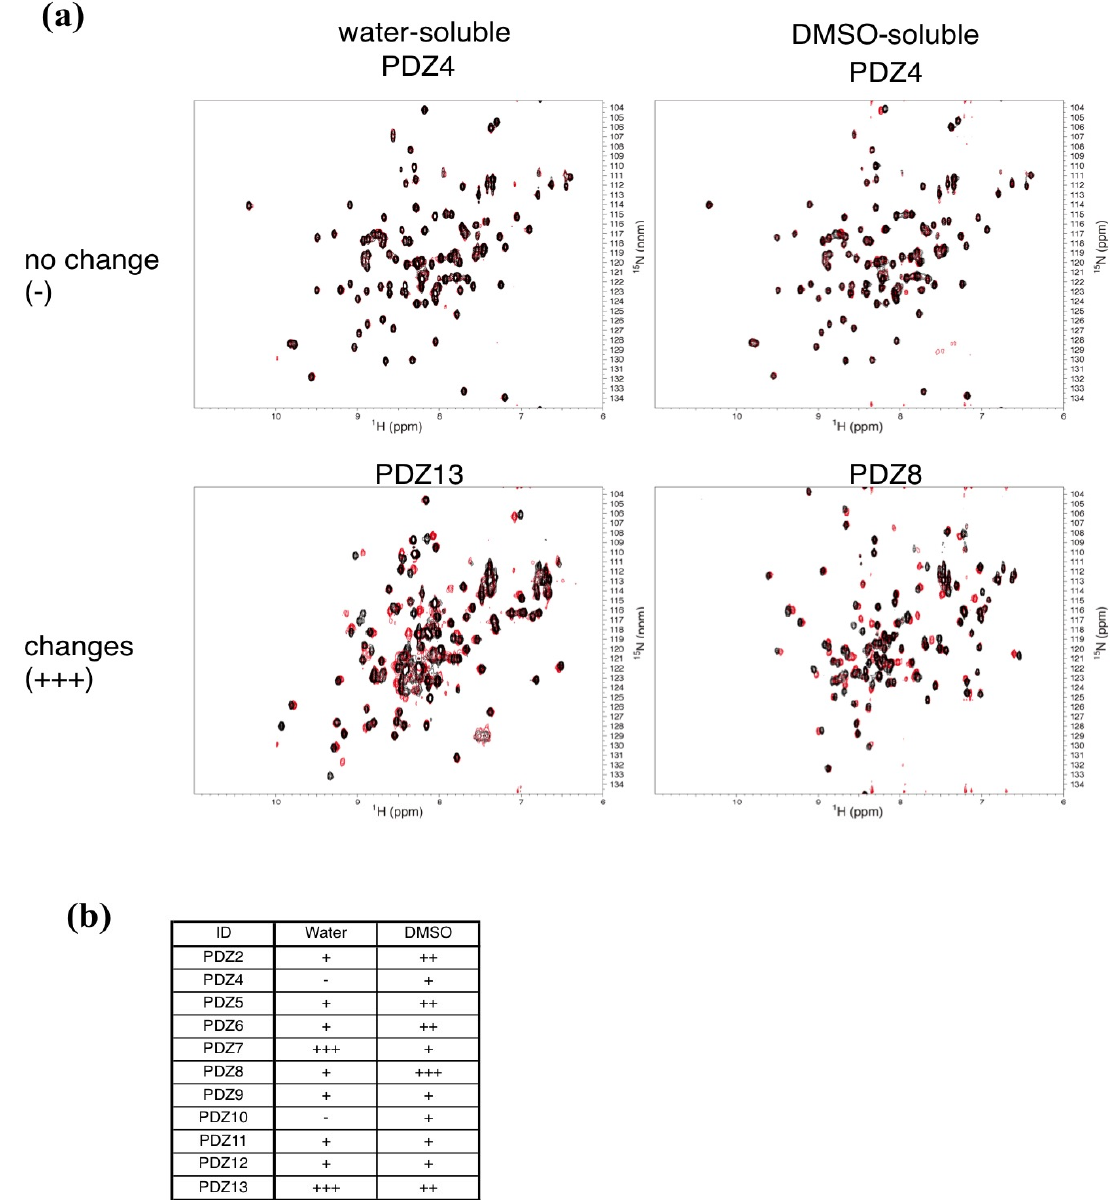
Figure 1. Examples of NMR-binding assay between PDZ domains and the compound cocktails. ( a ) Each overlaid spectrum was derived from a PDZ domain with (red) and without (black) cocktail. Upper spectra show that no signal changes were observed with mixing of the PDZ domains and a cocktail. Lower spectra show the signal changes when PDZ domains were mixed with a cocktail. ( b ) Summary table of binding assays using compound cocktails. The number of the plus signs indicates the degree of signal changes (+, less than 15 signals changed; ++, less than 30; +++, over 30, respectively). The minus sign indicates no signal changes. PDZ1, PDZ3, and PDZ14 were not